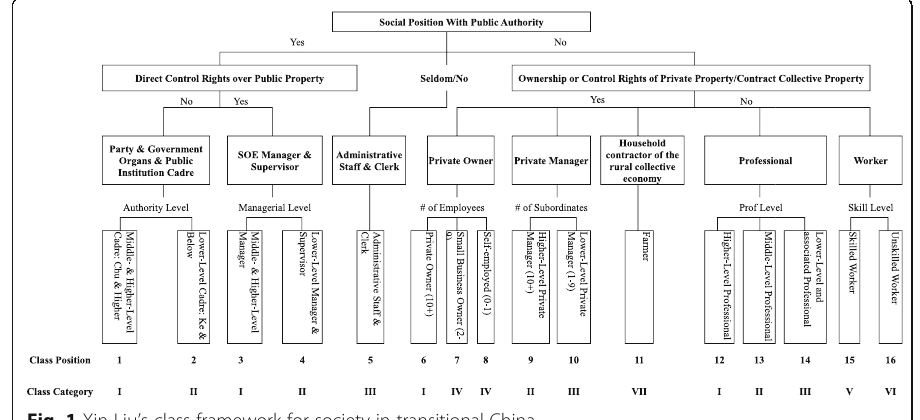
Fig. 1 Xin Liu ’ s class framework for society in transitional